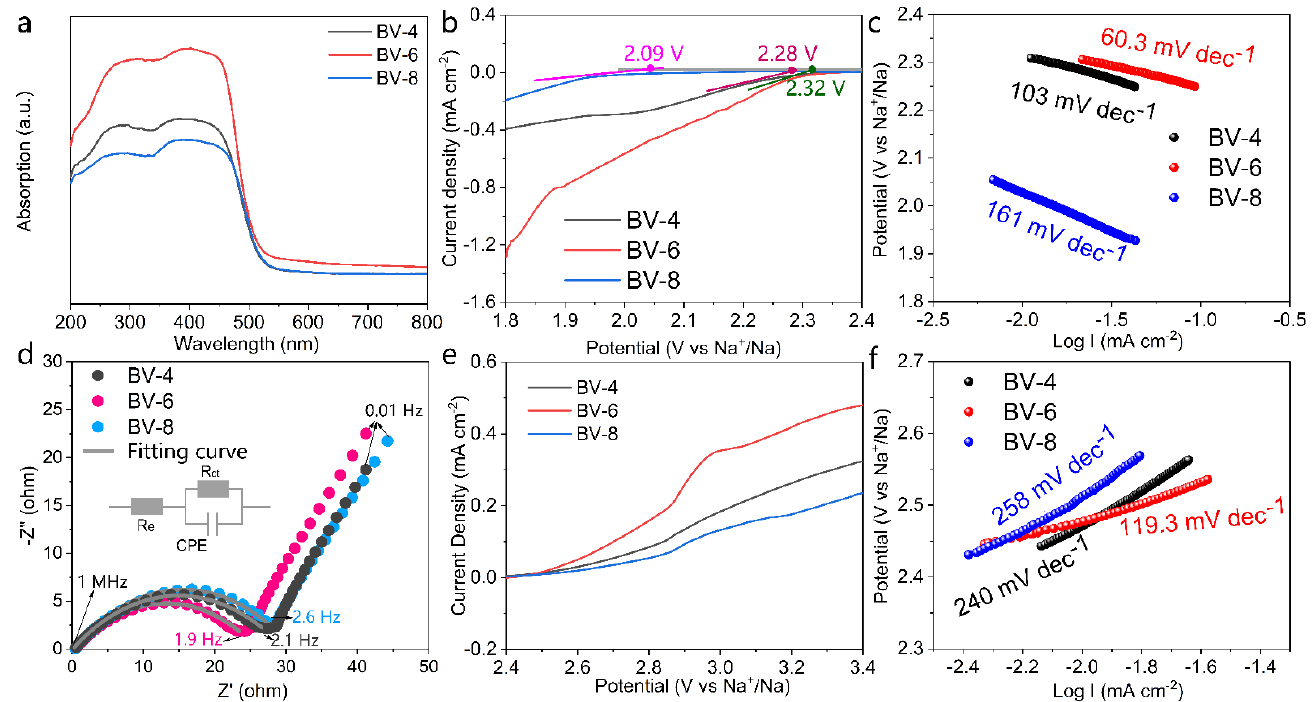
Figure 2. UV – visible absorption spectra ( a ), LSV curves for ORR at a scan rate of 0.1 mV s −1 ( b ), the corresponding Tafel slope for ORR ( c ), EIS ( d ), LSV curves for OER at a scan rate of 0.1 mV s −1 ( e ), and the corresponding Tafel slope for OER ( f ) of the BiVO 4 /CNTs electrode under illumination.